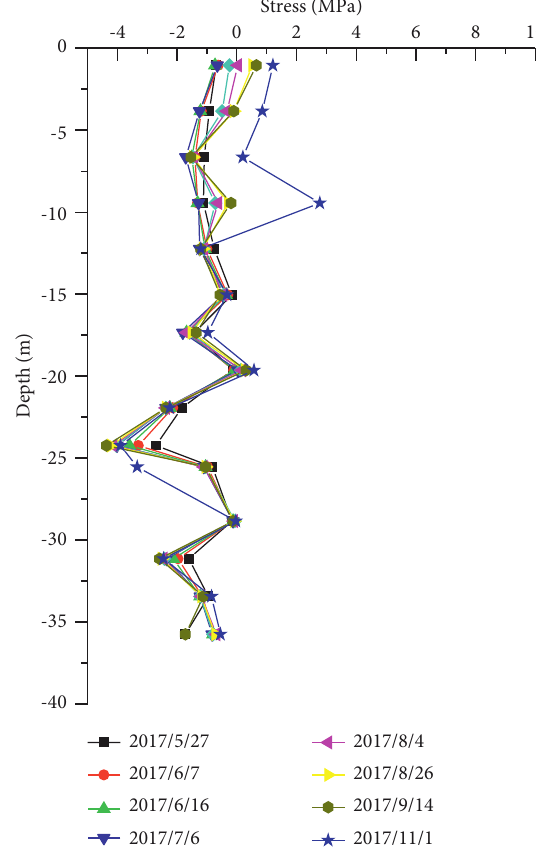
Figure 11: The body stress of 29# antislide pile during the earthquake.